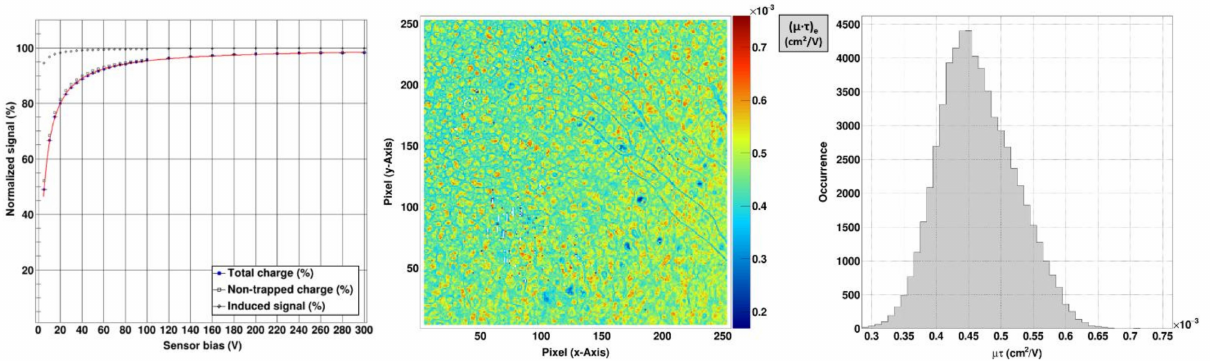
Figure 6. ( left ) Hecht curve of the GaAs:Cr (2017) sensor using molybdenum fluorescence photons with an energy of 17.4 keV. The data was fitted with equation 1 (red solid line). The mean ( µ · τ ) e is (4.730 ± 0.003) × 10 –4 cm 2 /V and the charge collection efficiency (CCE) at –300 V is 98.2%. ( middle ) Spatial distribution and ( right ) histogram of ( µ · τ ) e product of the whole sensor: From the distribution of ( µ · τ ) e values, extracted on a pixel-by-pixel basis, a mean value of (4.640 ± 0.002) × 10 –4 cm 2 /V with a dispersion of 12.7%. (The white squares in the map indicate pixel clusters which were masked due to too high noise and/or a pedestal value beyond